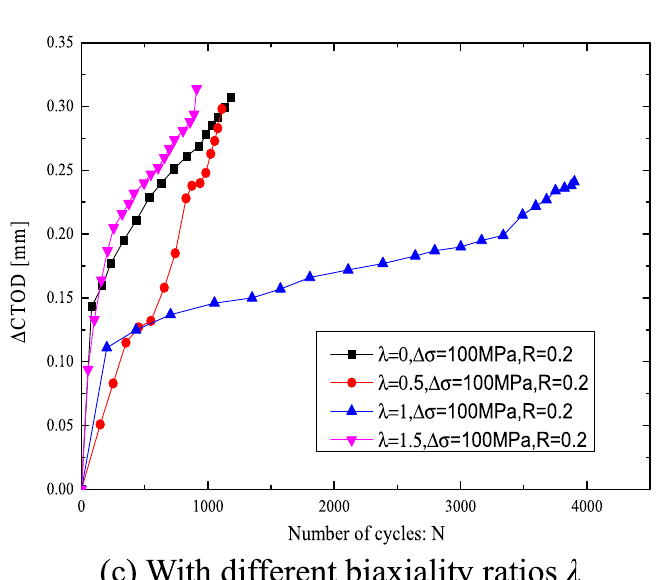
Fig. 10 Variation curves of ΔCTOD for different biaxial low-cycle fatigue